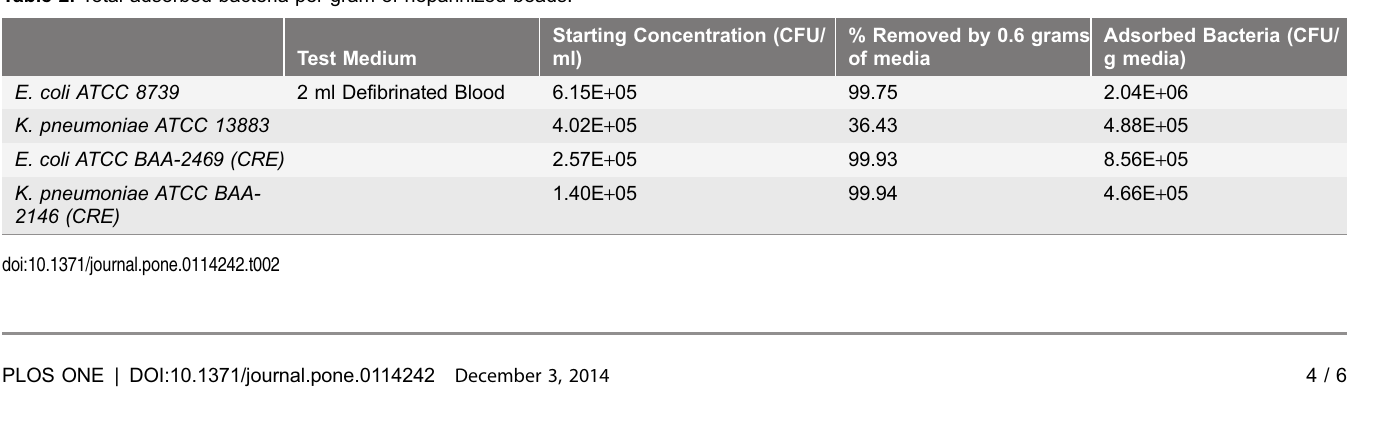
Table 2. Total adsorbed bacteria per gram of heparinized